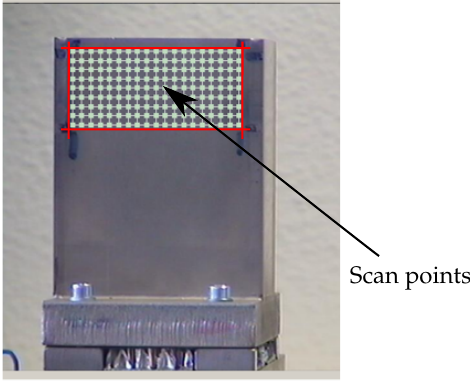
Figure 5. Linear shape grid consisting of 171 scan points.